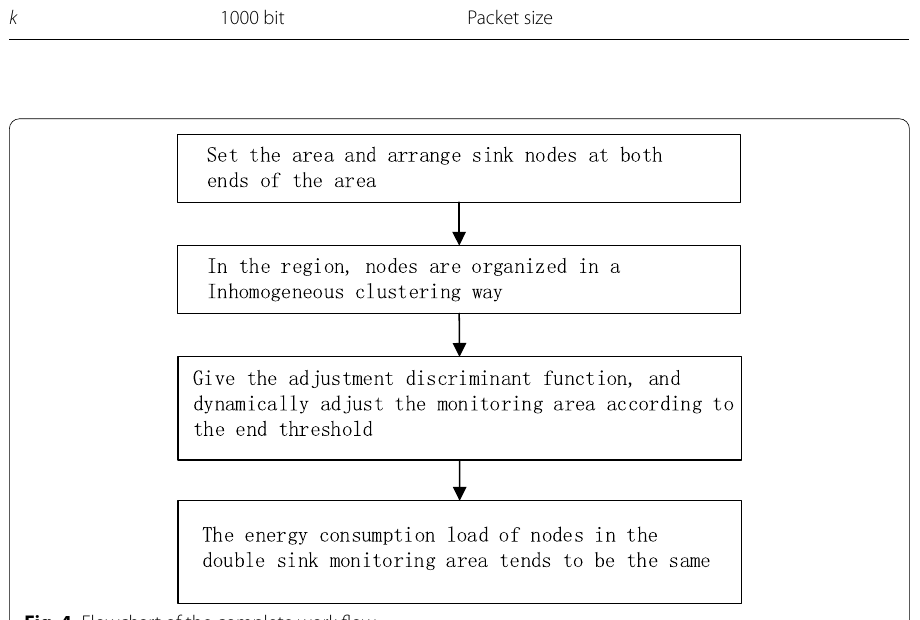
Fig. 4 Flowchart of the complete work